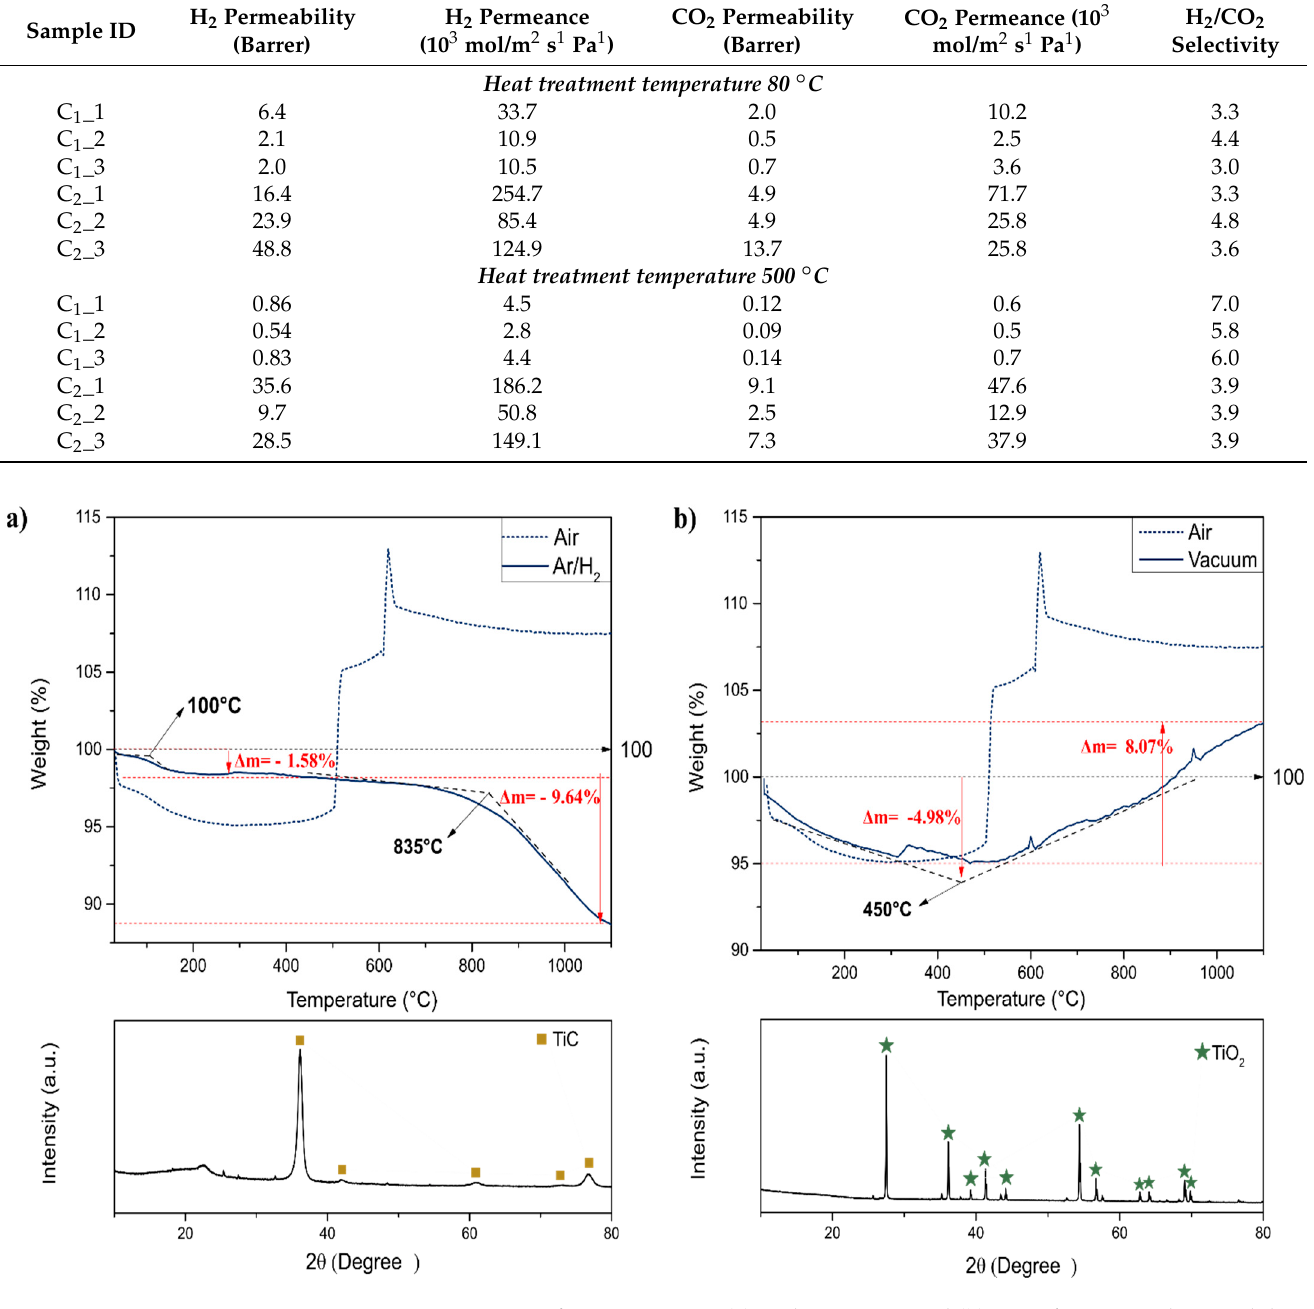
Figure 10. TG curves of T 3 C 2 T x MXene ( a ) under vacuum and ( b ) in H 2 /Ar atmosphere and their respective XRD patterns representing the phases which were formed after TG measurement.